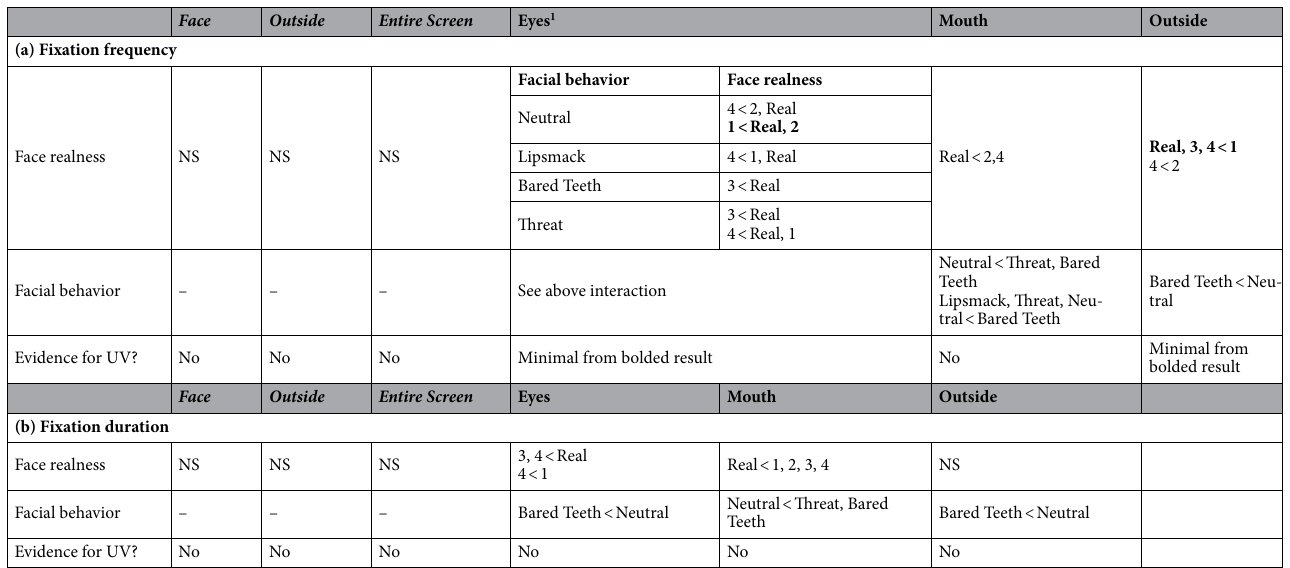
Table 1. Summary of results relevant to the UV. Outcome variables are fixation frequency ( a ) and fixation duration ( b ). Headings in italics represent replication analyses conducted with Friedman’s tests while headings in bold represent results from the expanded AOI analysis. The “–" denotes that the factor was not assessed in the model. Overall, there was very minimal support for the hypothesis that rhesus monkeys are sensitive to the UV effect (bolded results). 1 Results from a significant interaction between facial behavior and face realness are summarized within the cell for Face